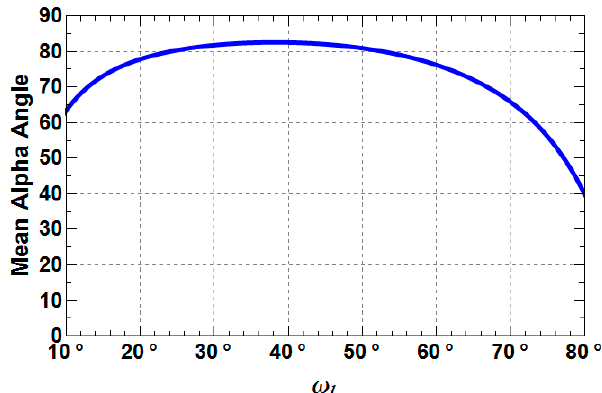
( ε s = 20, ε t = 10, L SXD = 1, ϕ = 0°, θ 1 = 60°).